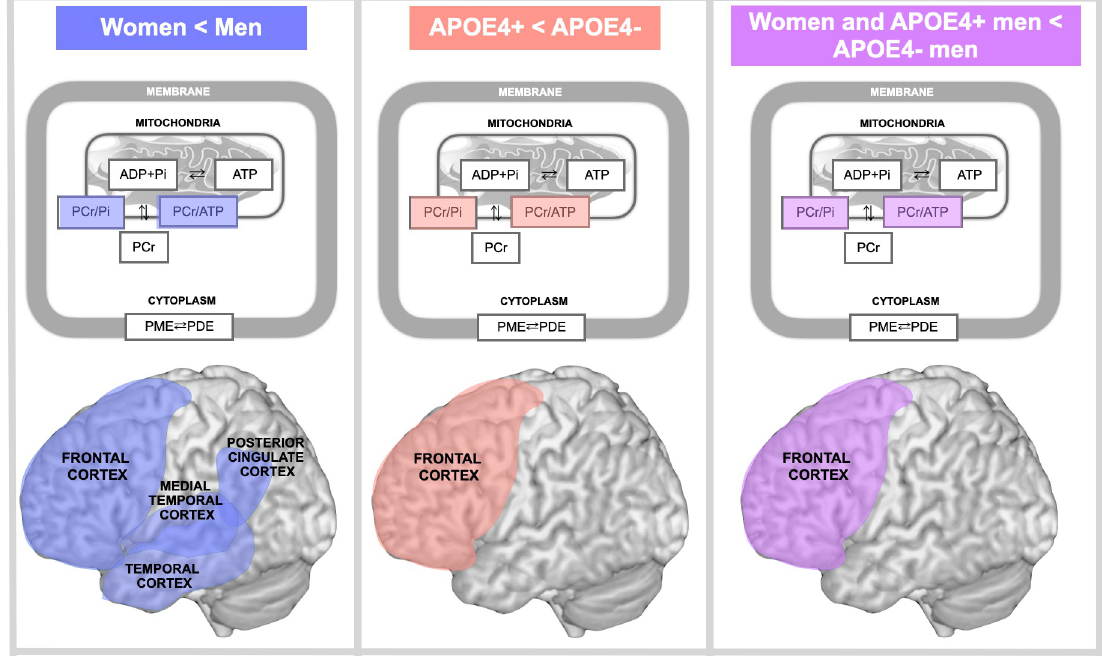
Fig 4. Schematic representation of sex and APOE4 status effects on midlife mitochondria phosphorus metabolites measured with 31 P-MRS. All panels: Phosphorus metabolites assessed with 31 P-MRS include phosphocreatine (PCr) rephosphorylated from creatine (Cr) using adenosine triphosphate (ATP) derived from chemical exchange of inorganic phosphate (Pi) and adenosine diphosphate (ADP) in mitochondria. Membrane phosphodiesters (PDE) and phosphomonoesters (PME) are also shown. Left panel: PCr/ATP and PCr/Pi are lower in women vs. men in frontal, temporal, medial temporal and posterior cingulate cortex (blue). Middle panel: PCr/ATP and PCr/Pi are lower in APOE4 carriers (APOE4+) vs. non-carriers (APOE4-) in frontal cortex (red). Right panel: PCr/ATP and PCr/Pi are lower in females and male APOE4 carriers vs. male non-carriers in frontal cortex